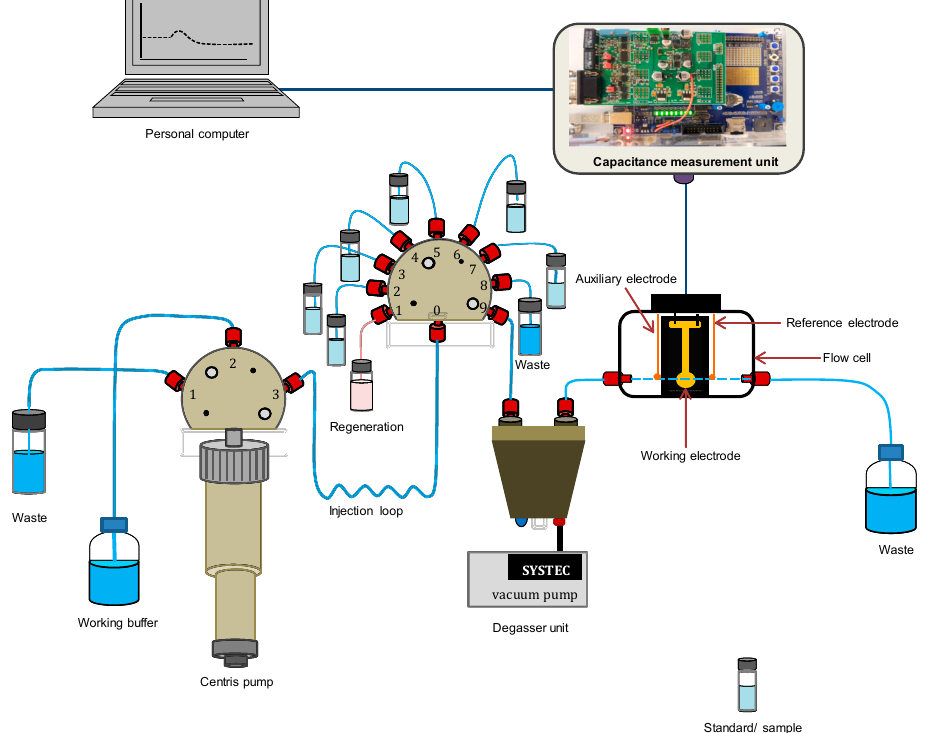
Figure 2. Schematic drawing of the flow-injection analytical system (CapSenze™ Biosystem). The CapSenze™ Biosystem consists of the Cavro Centris pump (Tecan, Crailsheim, When buffer is continuously pumped into the system and the current pulse is inter- Germany) integrated with a 3-port valve (also Tecan), which in turn is connected to a 9- mittently applied after every 60 s, the system will register a constant capacitance C, as a port valve via an injection loop. It also consists of a degasser unit, a three-electrode flow- baseline. However, the introduction of a target probe on the sensor chip hosting capture cell, and a CapSenze capacitance measurement unit [22]. Port #1 of the 3-port valve is used probes will lead to a hybridization reaction, which in turn results in a decrease in C. This as waste disposal during the initialization of the syringe pump. Port #2 is connected to the is due to the displacement of the counter ions from the electrode surface, as well as a working buffer (PB) solution in which the syringe plunger will suck and eject the PB so- reduction in the capture probe layer dielectric constant lution. The 9-port valve is used to automatically and serially inject 250 μ L of a stand- ard/sample and regeneration solutions into the flow cell via a degasser unit. The working buffer is continuously supplied to the flow cell by the syringe pump. The flow cell is con- nected to the capacitive biosensor, controlled by the software, and equipped with a resis- tor, which is connected between a potentiostat and the flow cell. Hence, an interrupted constant current pulse is supplied to the flow cell. The system has an inbuilt analog-to digital converter (ADC) unit. Therefore, the capacitance across the sensor chip/solution interface is automatically determined by the system from the slope of the potential curve (voltage vs. time) using Equation (2), as described elsewhere [22]. C = Q V = idt dV = i u (2) where C, Q and V are the total capacitance, accumulated charge and built-in potential across the sensor chip/solution interface, respectively; i is the electrical current supplied to the sensor chip; t is the current pulse period; u is the slope of the linear curve; and V is plotted against t. The total capacitance, C, across the sensor chip/solution interface is the sum of several capacitors in series Equation (3) [5,18]. 1 C =